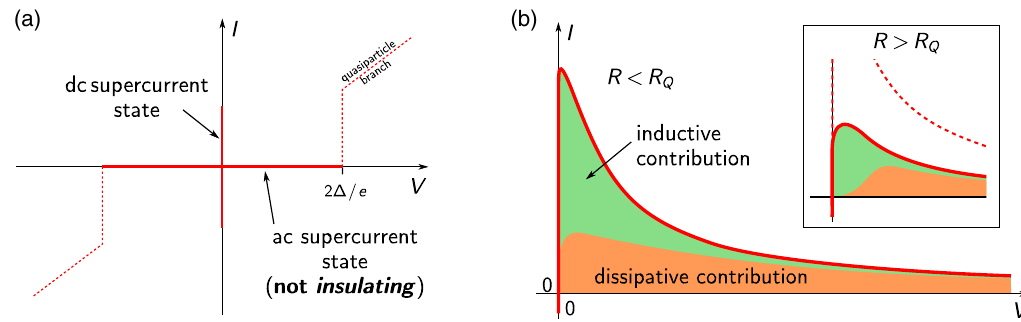
FIG. 1. (a) Predicted I − V characteristics of an unshunted Josephson junction. In that simple system, evaluating the dc mobility ð I=V Þ ¼ 0 erroneously suggests the junction is insulating, because it completely misses the ac Josephson supercurrent and μ ¼ lim V → 0 þ the dc supercurrent branch, the most remarkable features of that system. (b) Sketch of the top right quadrant of the I − V characteristic of a RSJJ, close to the origin (for R < R Q , see Ref. [47] in our article and, for R > R Q , Fig. S15 in Supplemental Material in Ref. [29] of our article). In contrast to the dissipationless unshunted case (a), one can now have a finite dc current at finite voltage, because the resistor can absorb the corresponding power. The total dc current has a contribution from the time evolution of the supercurrent not averaging to zero in the steady state, leading to a ground state inductive contribution ∝ E J h cos φ i at zero bias (green area) and a contribution arising from the dissipative Kubo term proportional to E 2 J (orange area). Most theory papers on the SB transition evaluate the dc mobility which captures the orange contribution only, overlooking [very much as discussed in (a)] the junction ’ s dynamical inductive (superconducting) response which dominates transport properties at equilibrium and close to it. Such dc mobility calculations indeed predict a transition, with a low-voltage suppression of the orange contribution at R > R Q , as shown in the inset [10]. However, the green contribution has no dissipative transition, because the equilibrium inductive response ∝ E J h cos φ i remains finite for all values of the resistance (although it is reduced at large R ), so that the RSJJ is always superconducting. Equilibrium transport properties are accurately characterized by dc mobility calculations only in open normal-state systems where one is certain to never have any